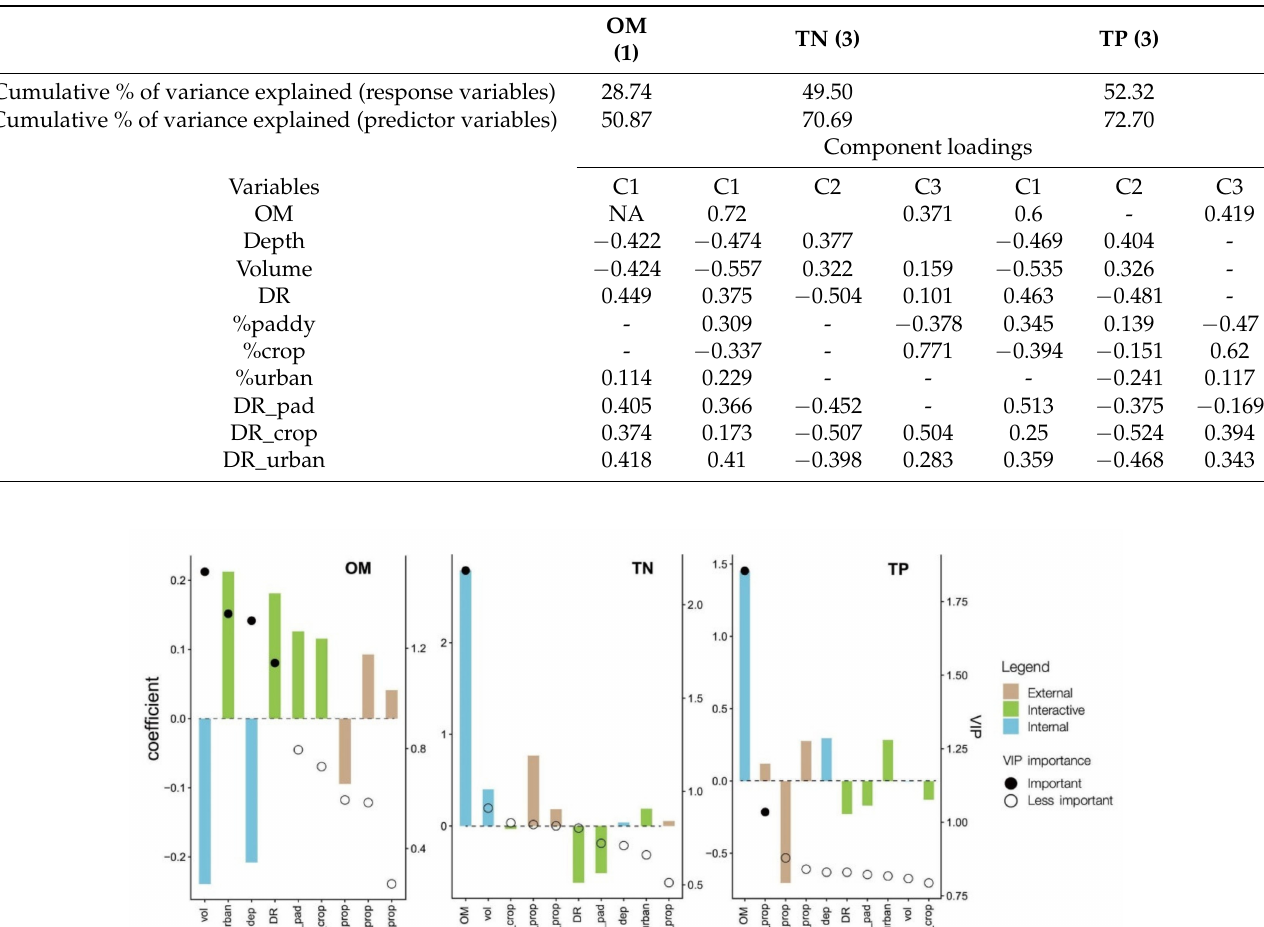
Table 4. Output of partial least square regression (PLS) relating predictor variables to change rates of three response variables of sediment characteristics (OM: organic matter content; TN: total nitrogen; TP: total phosphorus) in floodplain water bodies. Loading with absolute values less than 0.1 are not shown. For more information on abbreviations and symbols, refer to Table 3.